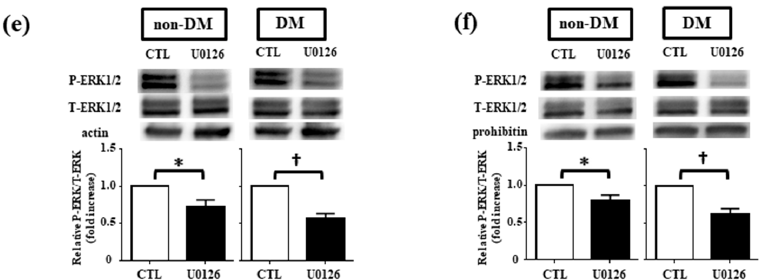
Figure 4. Effects of U0126 on ischemic resistance in DM hearts. Time courses of changes in LVDP ( a ) and LVEDP ( b ) during ischemia in non-DM hearts in the absence ( ● : n = 6) or presence of U0126 ( ▼ : n = 7). Values are means ± SEM. Time courses of changes in LVDP ( c ) and LVEDP ( d ) during ischemia in DM hearts in the absence ( ○ : n = 6) or presence of U0126 ( ▽ : n = 4). Values are the means ± SEM. * p < 0.05 vs. DM by two-way ANOVA. Effect of U0126 on whole cell ERK1/2 ( e ) and mitochondrial ERK1/2 ( f ). Representative Western blot analysis of ERK1/2 in both non-DM and DM hearts. Langendorff-perfused hearts were treated with U0126 for 70 min, and the phosphorylation levels of ERK1/2 were assessed. Data represent the fold-increase of phosphorylated/total ERK1/2 from non-treated CTL, and values are the means ± SEM of four independent experiments. * p < 0.05, † p < 0.01 vs. CTL (one-way ANOVA).